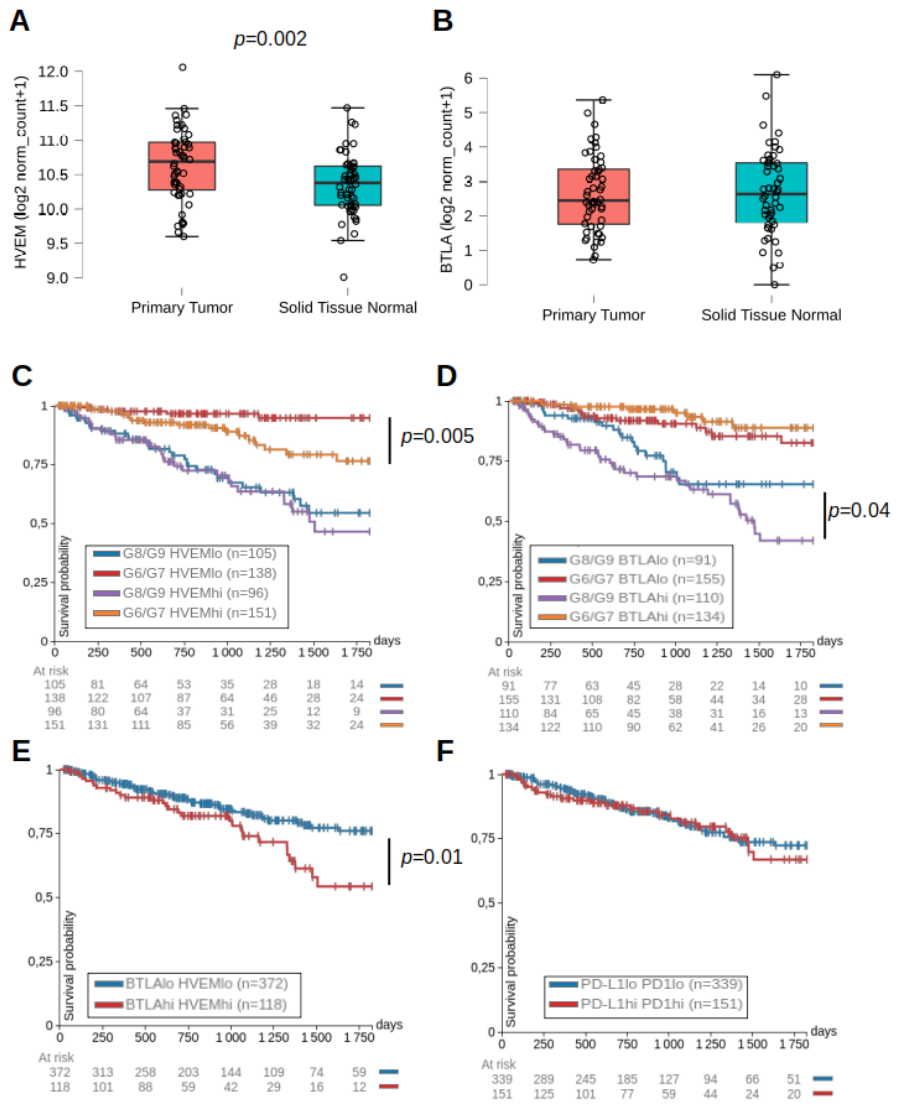
Figure 1. HVEM and BTLA were associated with lower progression-free intervals in prostate cancer patients. Expression of HVEM ( A ) and BTLA ( B ) mRNA (expressed as log 2 of normalized counts) in matched patients in the primary tumor or normal tissue ( n = 52). The p -value indicated on the graph is from a paired Student’s t -test with normality assumption validated by a Shapiro–Wilk test. Data were extracted from the PRAD dataset of the TCGA using Xena. Progression-free intervals (PFI) of PCa patients according to the level of expression of HVEM ( C ) or BTLA ( D ) and the Gleason scores signing low-grade (G6/G7) or high-grade (G8/G9) adenocarcinomas over a 5-year follow-up. For each group of clinical scores, patients were split into two groups according to below-median (HVEM lo or BTLA lo ) or above-median (HVEM hi or BTLA hi ) mRNA expression. PFI curves of PCa patients harboring below-median or above-median expression of both HVEM and BTLA ( E ) or both PD1 and PD-L1 ( F ) independently of clinical scores. The number of patients in each group is indicated in brackets and the number of patients at risk at main time points is indicated below the graph. The p -values on the graphs are from a log-rank test in Xena.